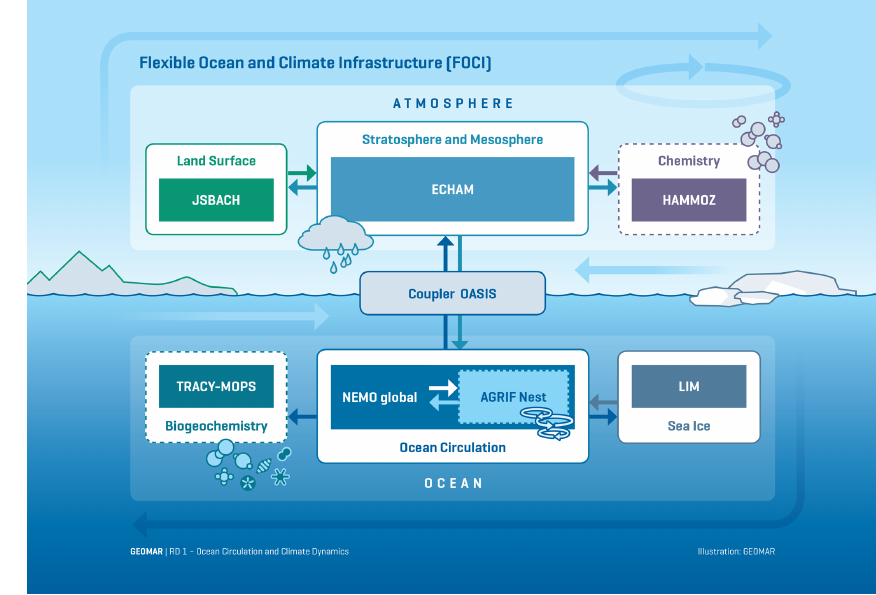
Figure 1. Schematic of the modeling system FOCI. Dashed boxes indicate optional